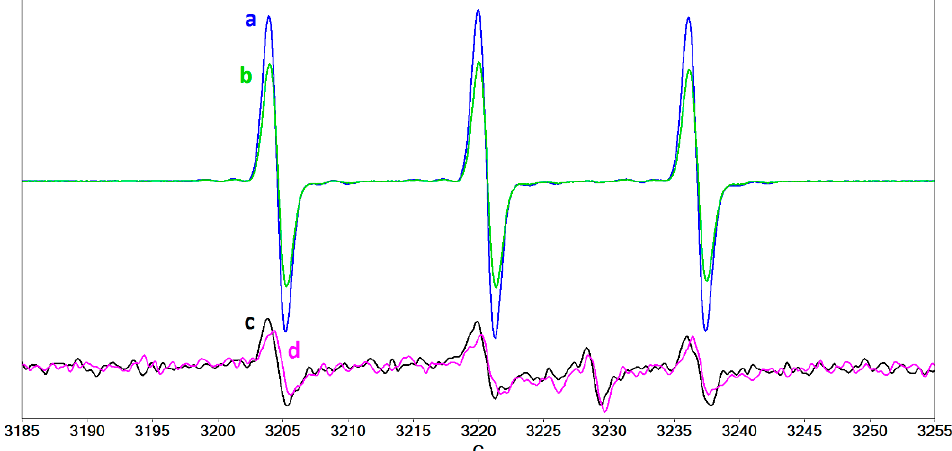
Figure 10. The EPR spectra of DMPO adducts formed after UVA exposure, in the presence of riboflavin, of collagen solution ( a ) in the absence of hyaluronic acid, ( b ) in the presence of hyaluronic acid, and ( c ) in the presence of the mixture of the three proteins and hyaluronic acid.